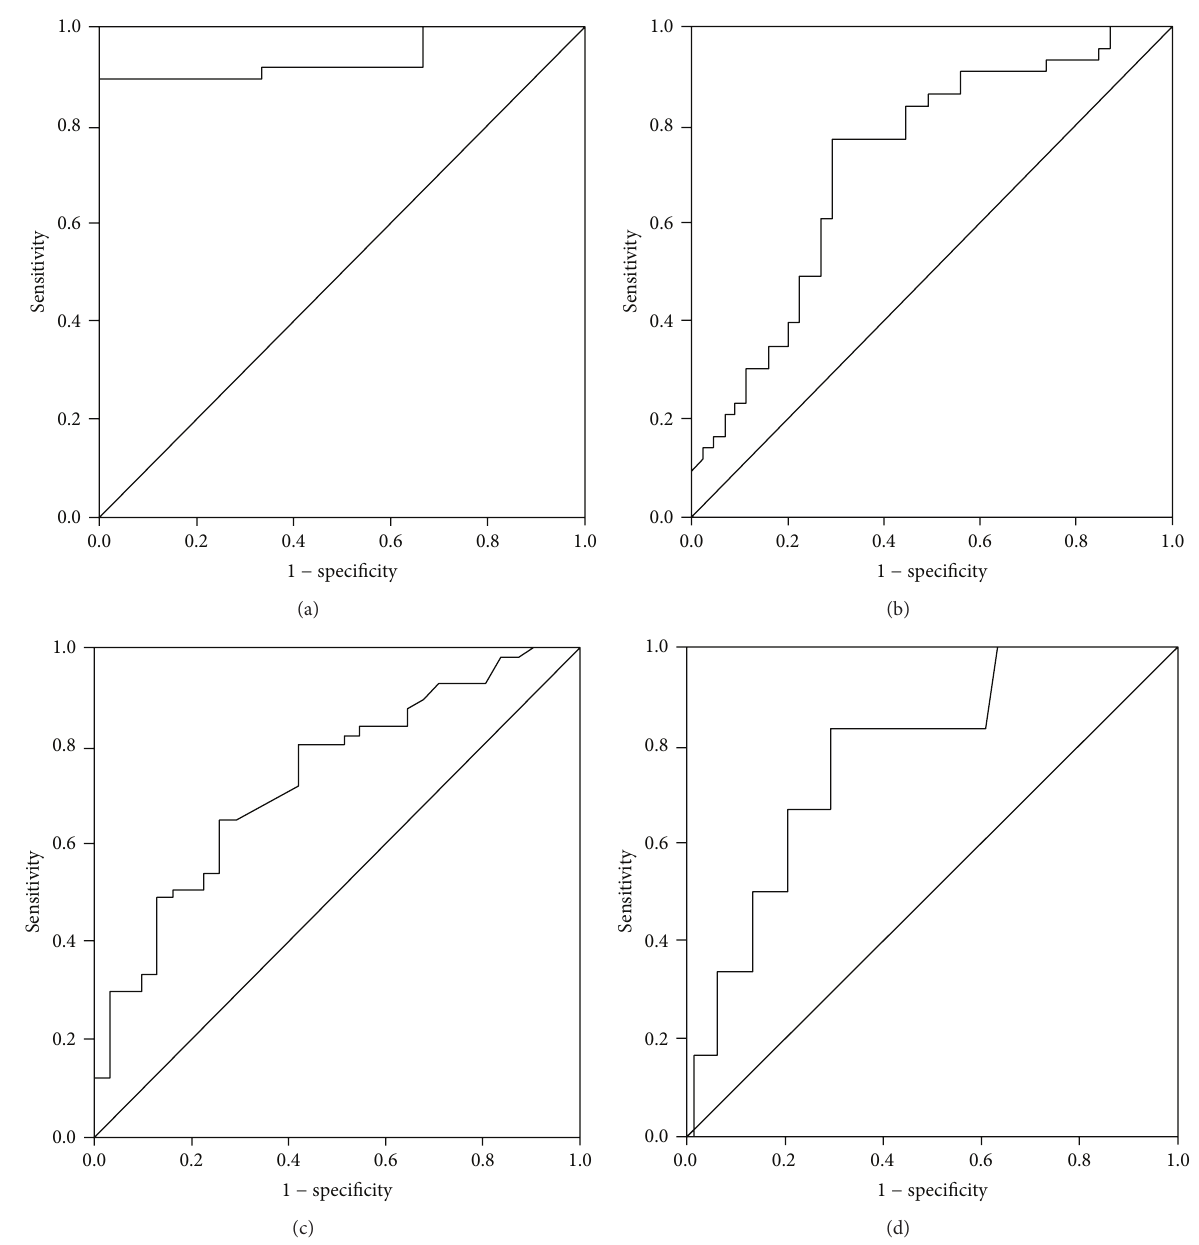
Figure 2: ROCs for fibrosis stages ( ≥ S1 and ≥ S2) were shown in (a) and (b), respectively, and for inflammation degrees ( ≥ G2 and ≥ G3) shown in (c) and (d), respectively, using APRI model.